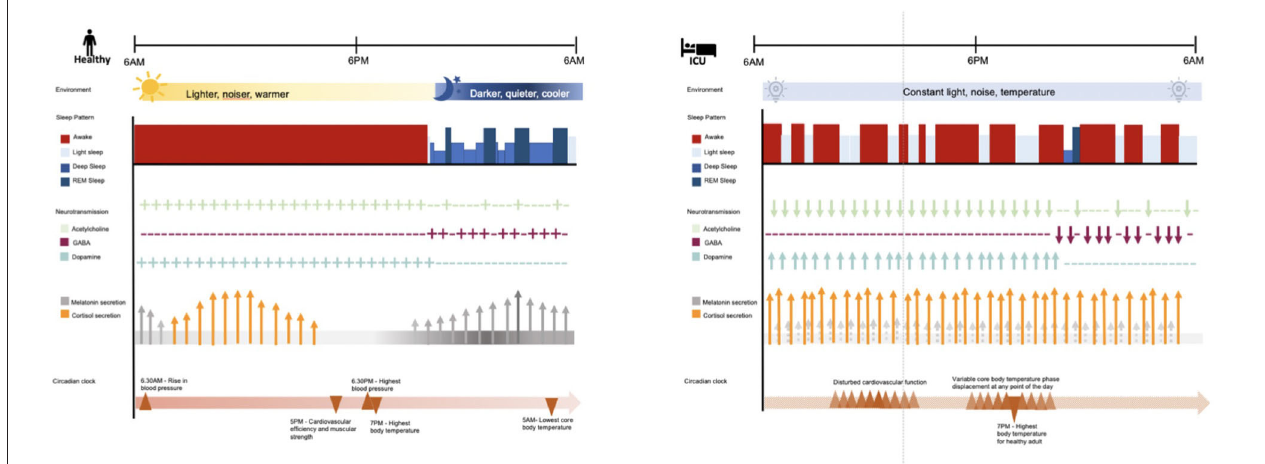
FIGURE 1 | Comparison of sleep and circadian rhythms in healthy adult and adult with critical illness in the ICU. In a healthy adult, the circadian clock is synced to the daily external cycle of changing light, sound, and temperature. The sleep stage of a healthy adult occurs during the night and is composed of 2–5% light sleep, 48–70% deep sleep, 20–25% rapid eye movement (REM) sleep. REM sleep reoccurs in cycles of 90–120min. Acetylcholine is predominantly discharged during wakefulness and REM sleep; while GABAergic activity is predominant during deep sleep. Dopaminergic activity promotes alertness and reduces sleep. Melatonin secretion starts around 9.30 pm (dim light melatonin onset) and stops around 7.30 am, peaking around 3 am. Cortisol secretion starts in the early morning, peaks around 10 am in correspondence to the time of highest alertness, and keeps declining gradually throughout the day, and the night. Overall, these